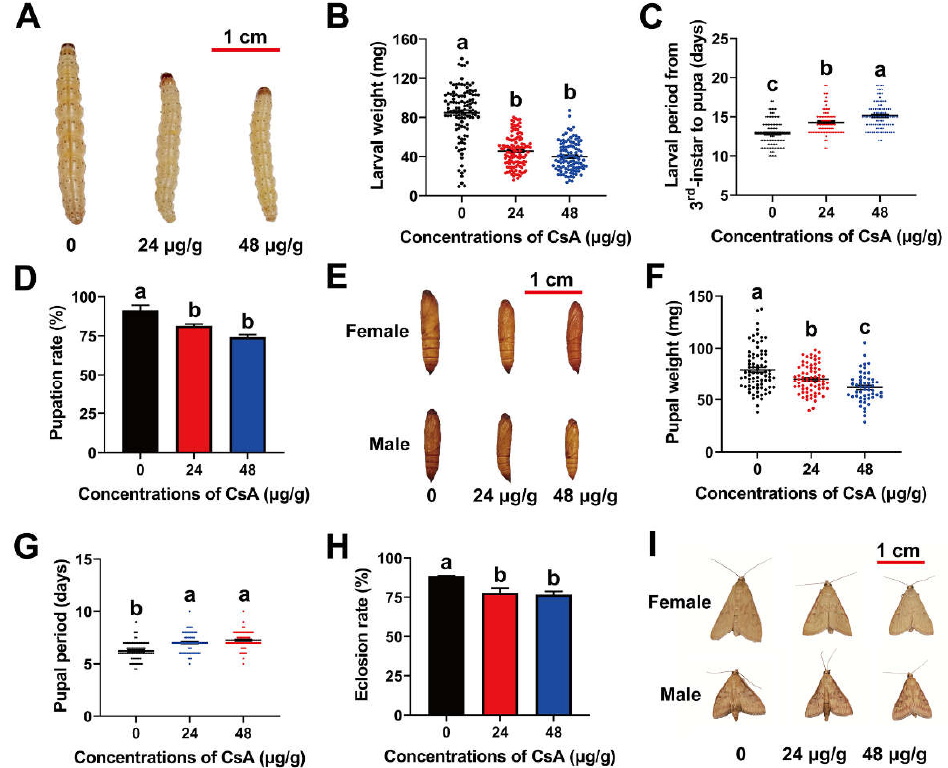
Figure 1. Sublethal effects of CsA on O. furnacalis larvae, pupae, and adults. ( A – C ) The body size ( A ), weight ( B ), and larval period ( C ) of the larvae after treatment with 0, 24, and 48 μg/g of CsA for 8 days. ( D ) Pupation rate under the different treatments of CsA. ( E – G ) Effects of CsA on the body size ( E ), weight ( F ), and period ( G ) of the pupae. ( H ) Emergence rate under the different treatments of CsA. ( I ) Phenotype of adults under each treatment. Data are means ± SE of more than three biological replicates. The significant differences were analyzed using ANOVA followed by Tukey’s (equal variances assumed) or Dunnett’s T3 (equal variances not assumed) HSD test on SPSS Statistics 20. Different lowercase letters indicate significant differences at the level of p < 0.05.